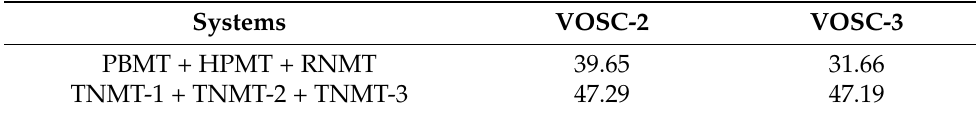
Table 8. Results for different voting models on test